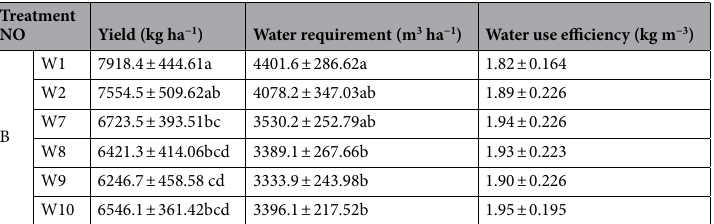
Table 5. Significance of differences of both rice grain yield and water requirement under conditions of soil water deficit (Duncan). The actual soil moisture content of the field was determined as a percentage of field capacity(θ), reflecting the degree of soil water deficit. In group A, WI:100% of field capacity; W2:90–100% of field capacity; W3:80–90% of field capacity; W4:70–80% of field capacity; W5:60–70% of field capacity; and W6:50–60% of field capacity. In group B, soil moisture deficit conditions were applied at different growth stages. W7: a filling stage deficit (70–80% of field capacity); W8: a flowering stage deficit (70–80%); W9: a booting stage deficit (70–80%); and W10: a tillering stage deficit (70–80%). The relative soil water content during the other growth stages was maintained at 80–90% of field capacity. Data in the table was the average and standard error of 3 years. Different letters after data in the table mean significant at 5% level.